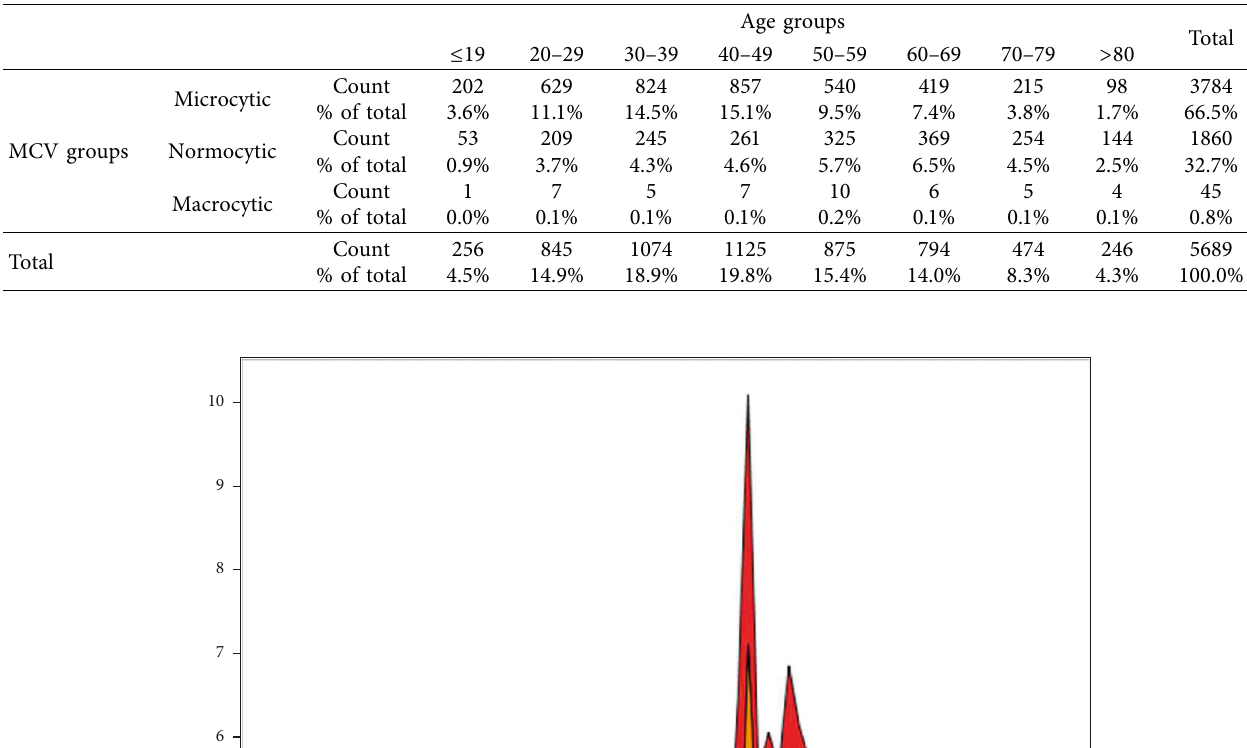
Table 6: Prevalence of morphological types of anemias across age groups in females.